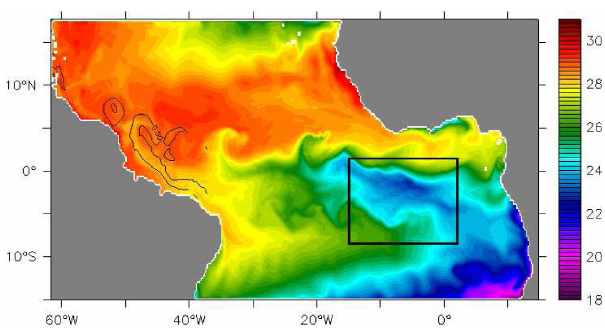
Fig. 1. TATL4 configuration: sea surface temperature is colored and exhibits the development of TIWs in the center of the basin; black contours indicate the 0.5ms − 1 iso-velocity at 30m depth, exhibiting the north Brazil current and the rings formation. The black square boxe illustrates the influence zone of an observation (see Sect. 3.5).